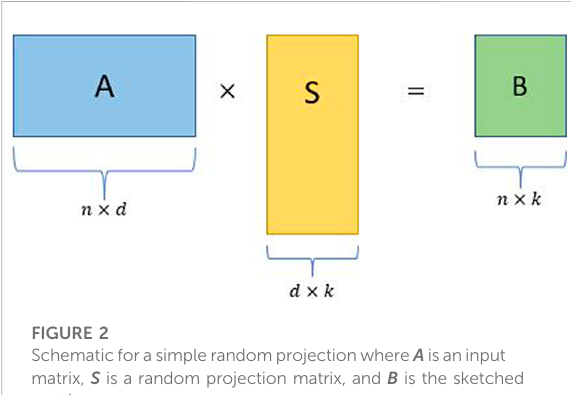
FIGURE 2 Schematicforasimplerandomprojectionwhere A isaninput matrix, S is a random projection matrix, and B is the sketched